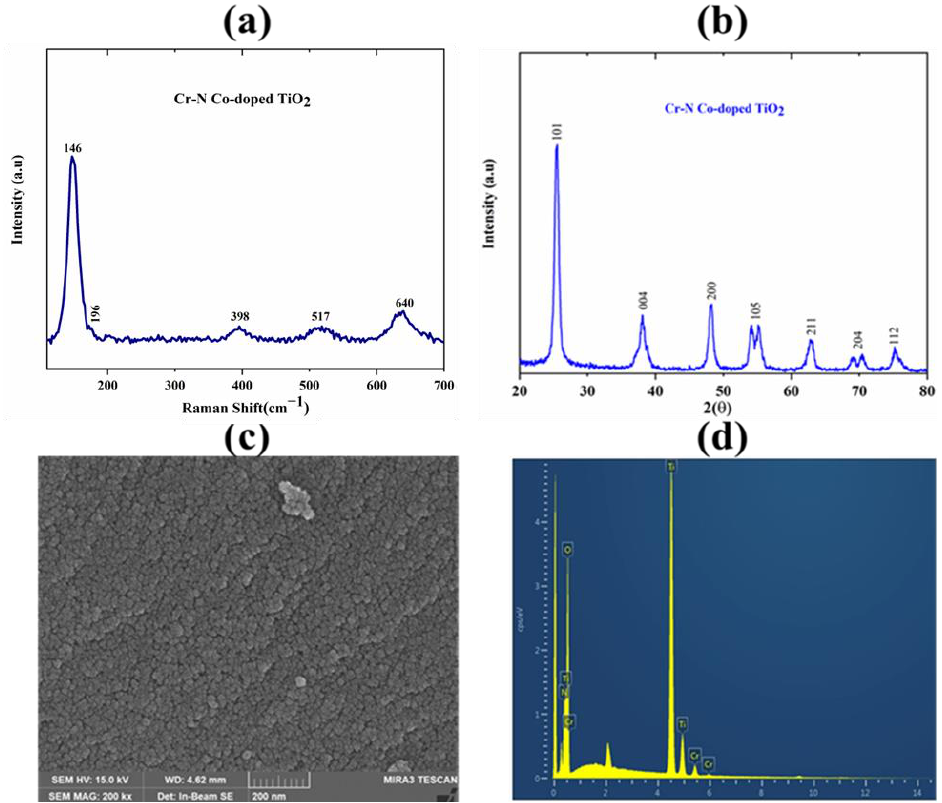
Figure 2. Material characterizations: ( a ) Raman scattering showing active optical phonon modes relevant to anatase structure of Cr-N-doped TiO 2 NPs. ( b ) X-ray diffraction patterns indicating the single-phase anatase crystalline structure. ( c ) FESEM image of Cr-N doped TiO 2 NPs showing homogeneous crystalline shape and size. ( d ) EDS spectra displaying the presence of chromium and nitrogen in crystalline matrix of TiO 2.